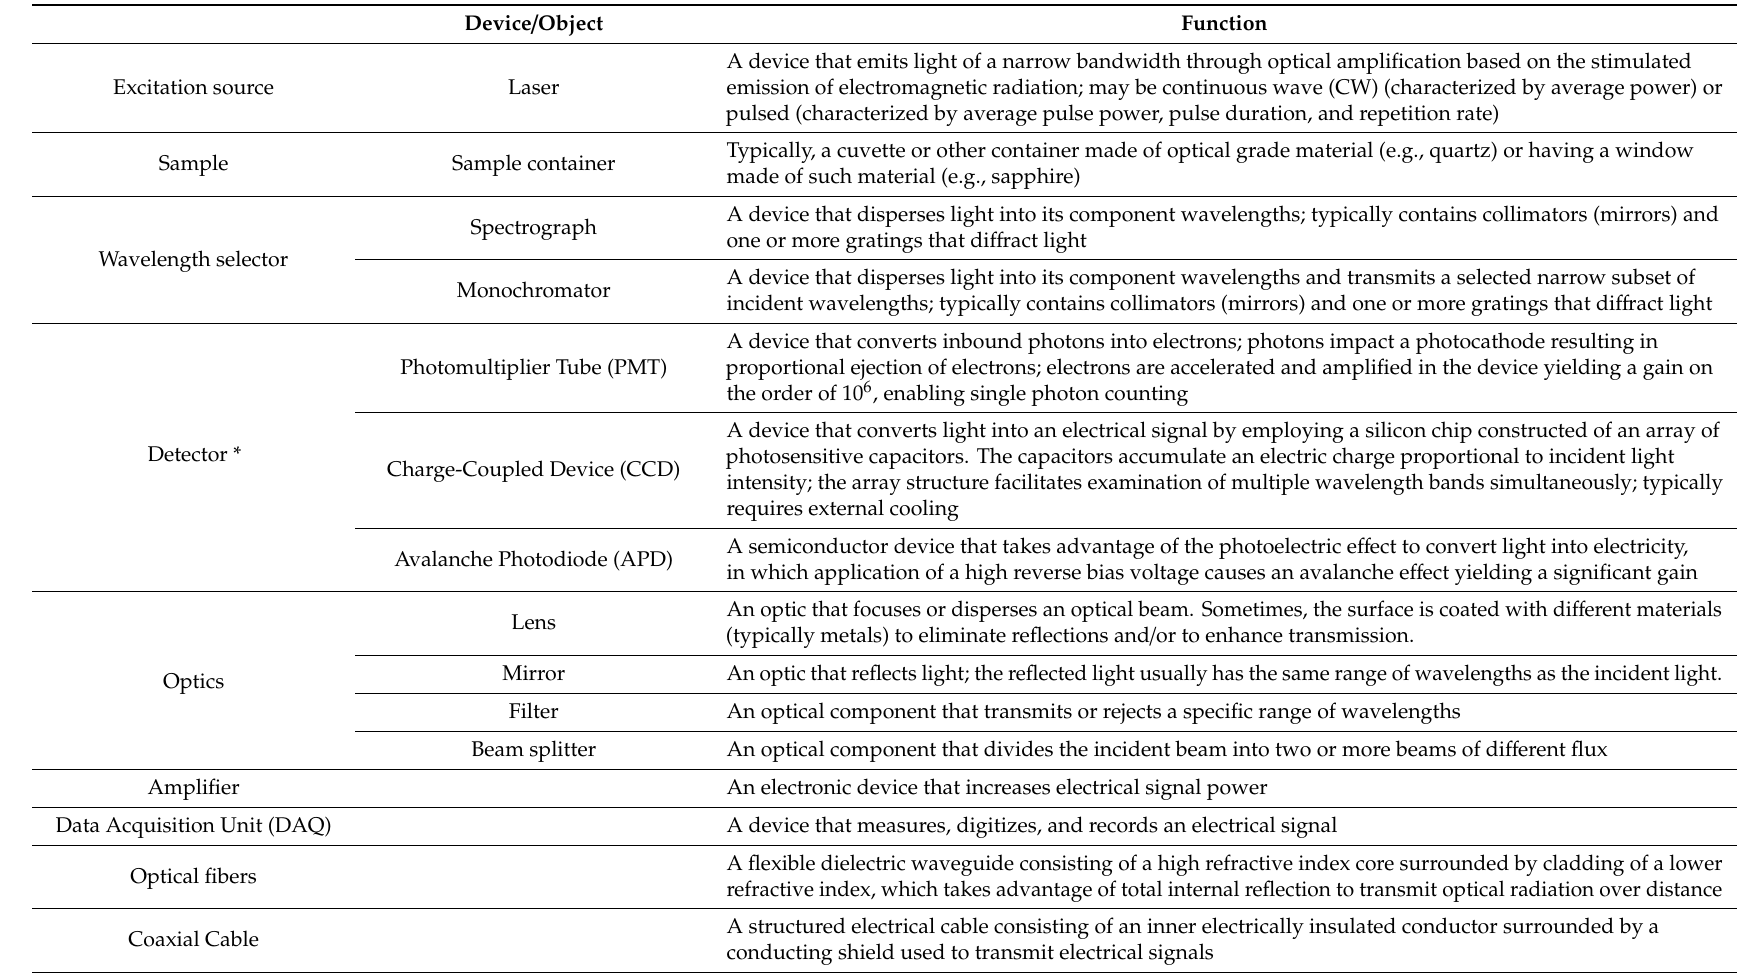
Table 1. Common components in a Raman spectroscopic